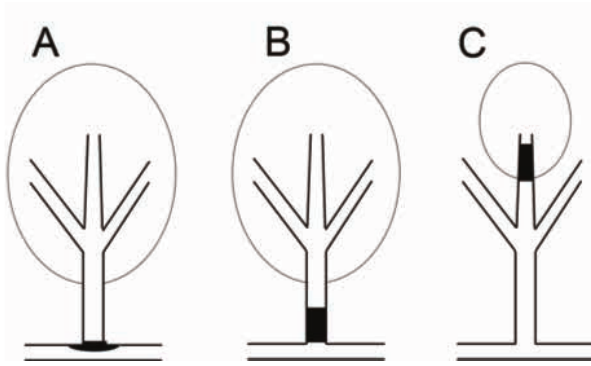
Figure 1: Proposed mechanistic model of isolated pontine infarc- tion. (A) Paramedian pontine infarction (PPI) that results from plaque in the parent artery blocking the branch orifice. (B) Para- median pontine infarction (PPI) that results from a microatheroma in the orifice of the branch. (C) Lacunar pontine infarction (LPI) that results from fibrinoid necrosis or lipohyalinosis of the distal perforating